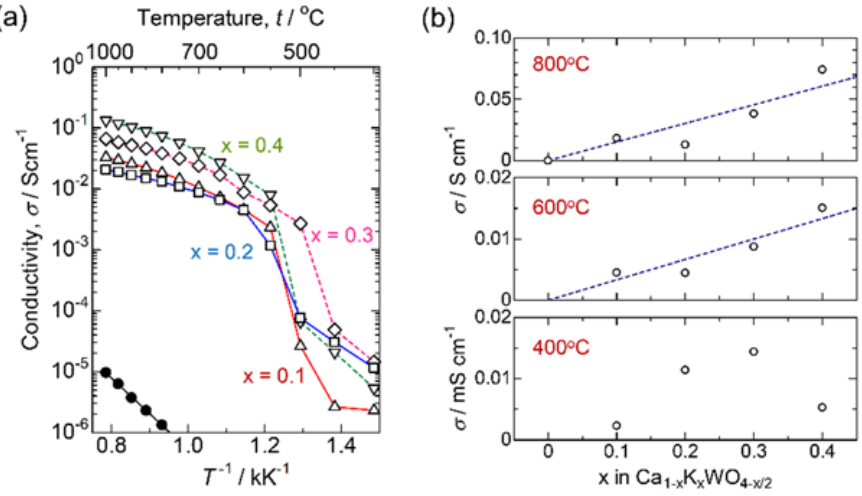
Figure 3. ( a ) Arrhenius plot of conductivity for Ca 1 − x K x WO 4 − x/2 . ● : x = 0, : 0.1, : 0.2, : 0.3, and : 0.4; ( b ) Conductivity isotherms of Ca 1 − x K x WO 4 − x/2 at 400, 600, and 800 °C.